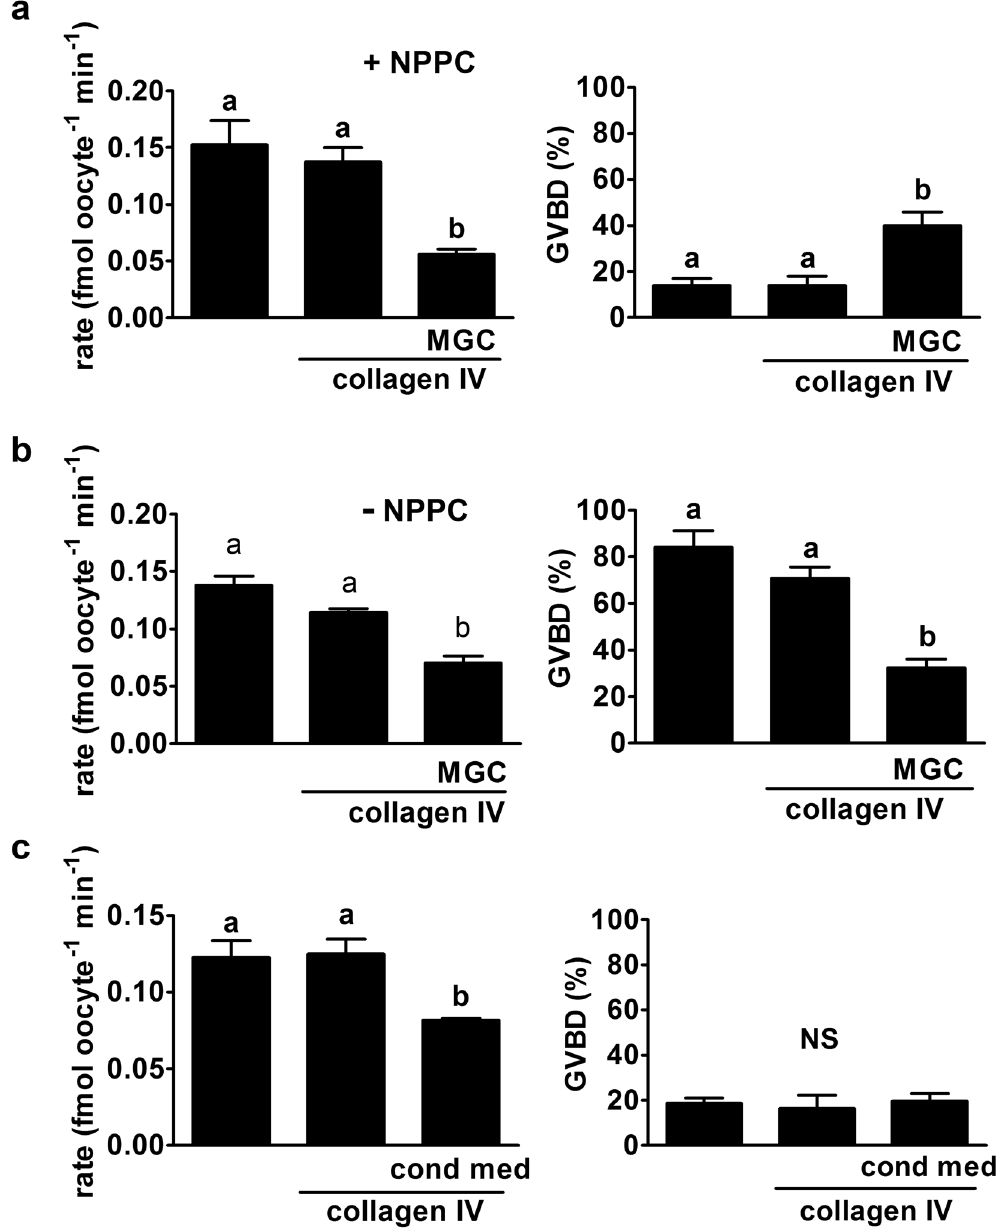
Figure 4. Effect of co-culture of COCs on MGC monolayers. ( a ) COCs were cultured for 4 h in plastic wells, on collagen IV alone, or on a MGC monolayer on collagen IV as indicated at bottom. Oocytes were then isolated, GV status determined (right) and GLYT1 activity measured (left). GLYT1 was similarly activated within COCs on plastic alone or on collagen IV, but the development of activity was significantly suppressed in the presence of MGC (overall: P = 0.007; a vs b: P < 0.05). GVBD was inhibited in all three groups, since NPPC was present during COC culture, although there was a small but significant increase in the presence of MGC (overall P = 0.009; a vs. b: P < 0.05). Each bar represents the mean ± s.e.m. of three independent repeats. Throughout ( a–c ), data were analysed by ANOVA with Tukey test. ( b ) The same groups were again assessed, except that NPPC was absent. MGC again suppressed GLYT1 activity (left; overall, P < 0.0001; a vs. b: P < 0.001) and were also sufficient to inhibit GVBD (right: overall, P < 0.0001; a vs. b: P < 0.001) even in the absence of exogenous NPPC. Each bar represents the mean ± s.e.m. of five independent repeats. ( c ) The effect of conditioned media from each of the treatment groups in (A) with NPPC present during COC culture was assessed. Conditioned medium from MGC, but not plastic or collagen IV alone, significantly suppressed GLYT1 activation (left; (overall P = 0.018; a vs. b: P < 0.05). GVBD was equally prevented in all three groups (right; P = 0.84; not significant, NS). Each bar represents the mean ± s.e.m. of three independent